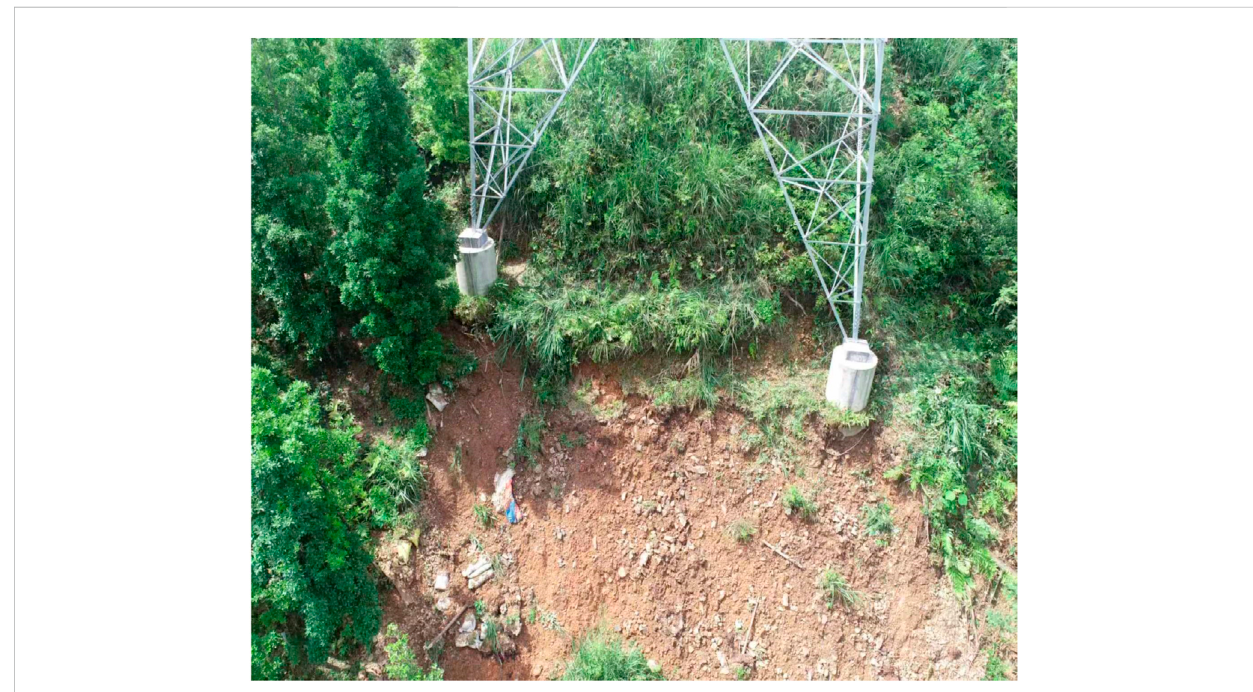
FIGURE 1 Potential geo-hazard of the pile foundationof a transmission tower built near a slope inBaisecity, Guangxi province of China (photograph from the investigation of